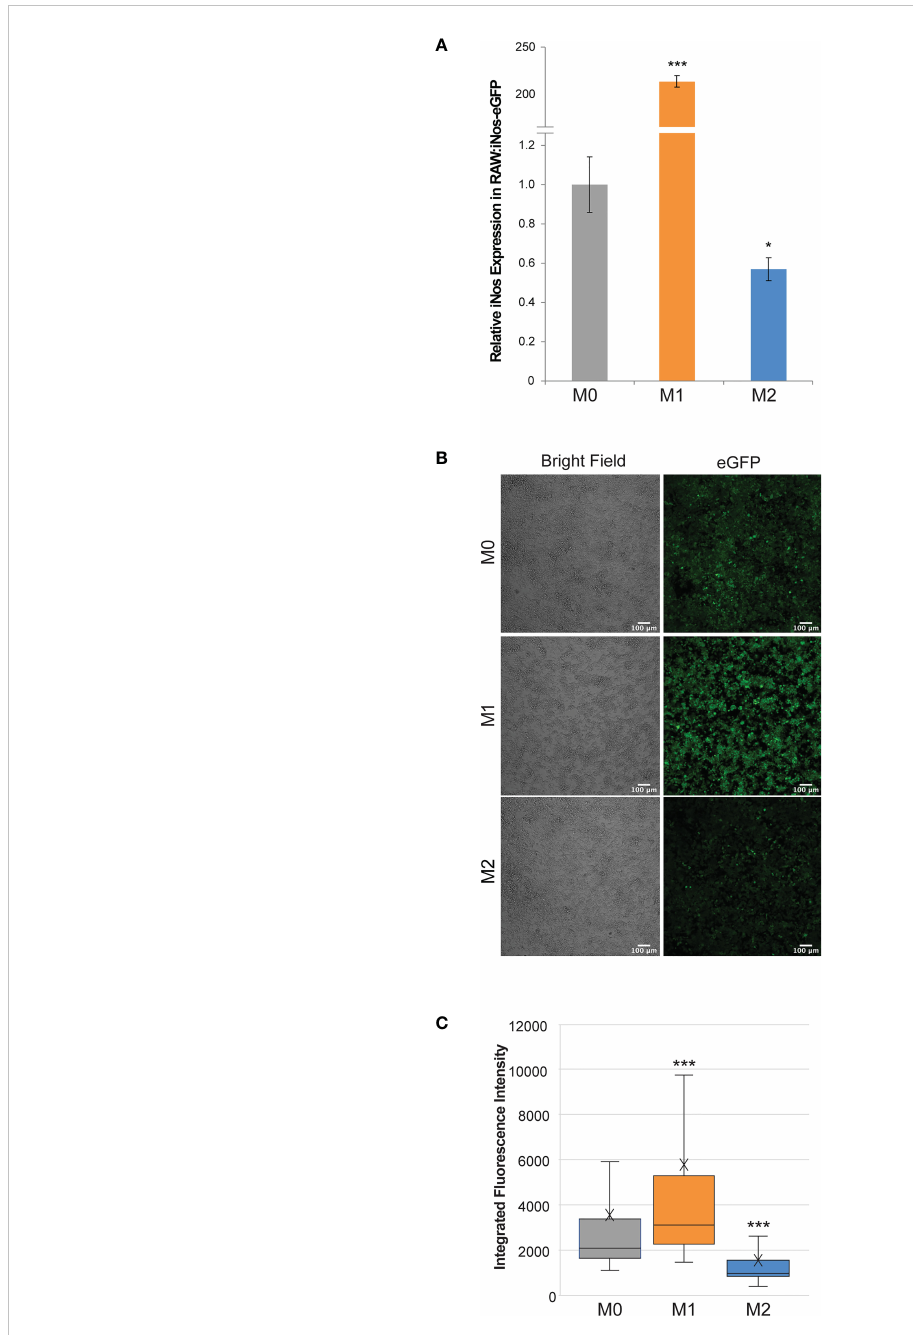
FIGURE 1 Effects of cytokine polarization on RAW:iNos-eGFP cells. (A) RT-PCR data showing relative levels of iNos mRNA across polarization states (M0 = gray, M1 = orange, and M2 = blue), where M1 results in the highest levels. Error bars represent standard error. (B) Confocal microscopy images acquired following polarization of RAW: iNos -eGFP show that the M1-polarized cells have the greatest fl uorescence intensity. eGFP = enhanced green fl uorescent protein. Scale bars on confocal images represent 100 µm. (C) Quanti fi cation of fl uorescence intensity on a per-cell basis from the fi gures shown on the left con fi rm that the M1 state results in the highest fl uorescence intensity. M0 = gray (n = 1,710), M1 = orange (n = 1,820), and M2 = blue (n = 1,142). The “ x ” in the box represents the mean; the bottom and top lines of the box represent the median of the bottom half (1st quartile) and median of the top half (3rd quartile), respectively; the line in the middle of the box represents the median; the whiskers extend from the ends of the box to the minimum value and maximum value. For all panels, M0 = non-treated; M1 = LPS/IFN- g ; M2 = IL-4. For (A, C) , Student T-test was used for statistical analysis comparing M1 and M2 macrophages to M0 (p<0.05 = *, p<0.001 =